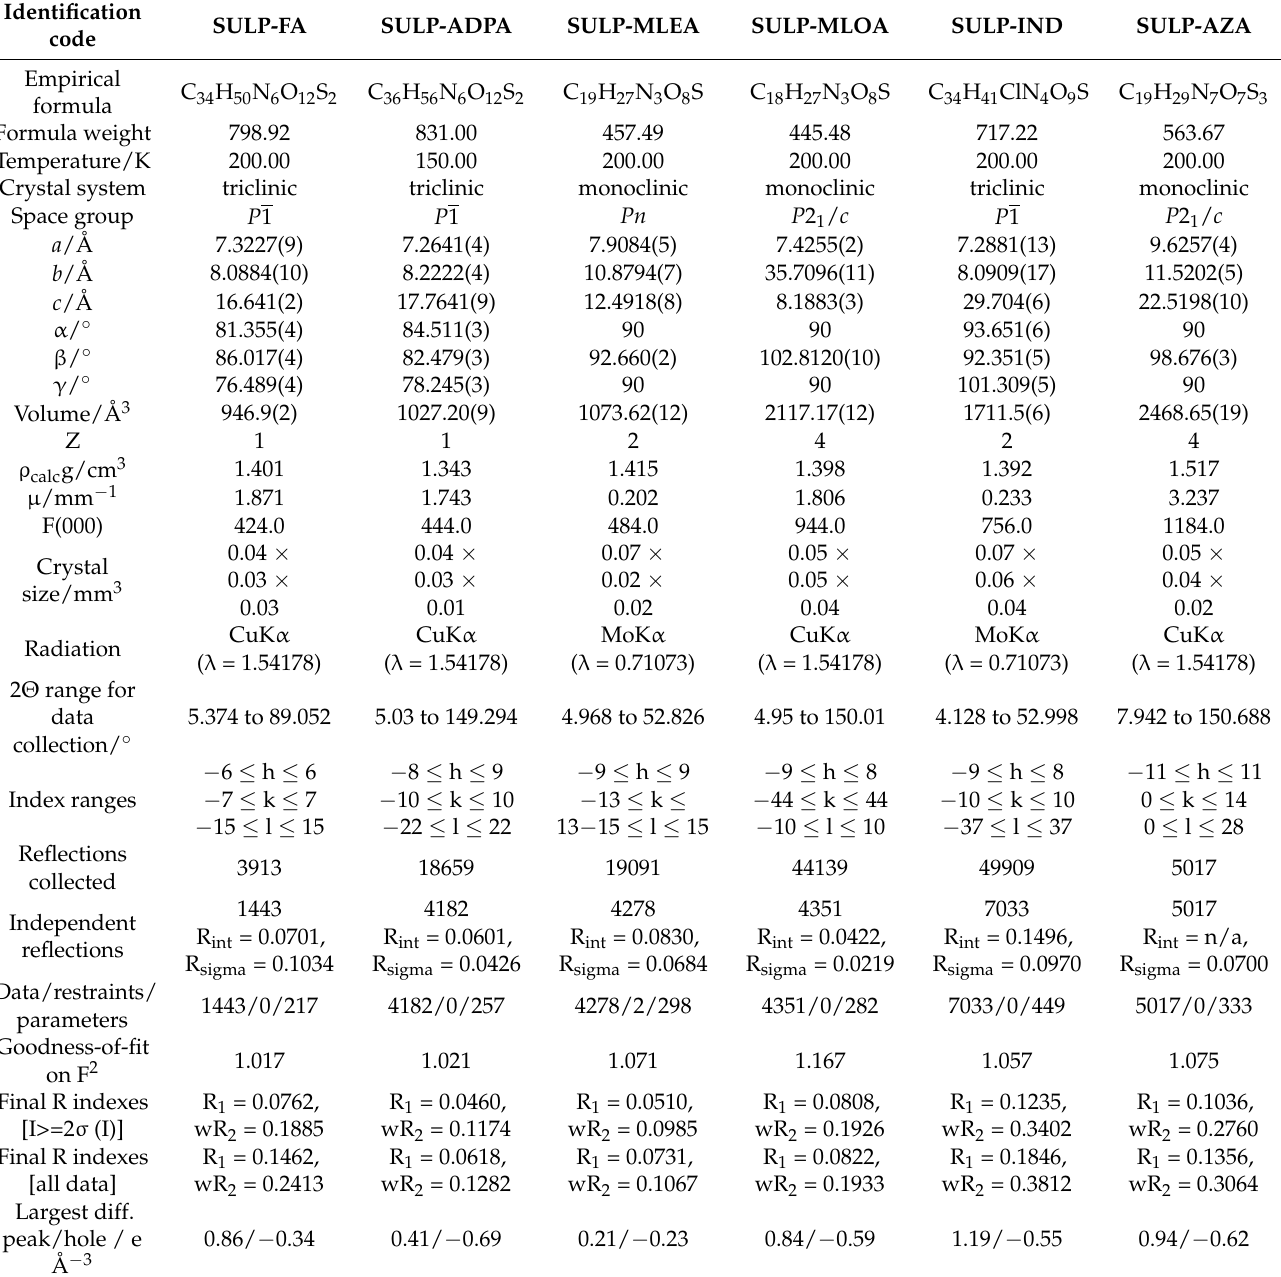
Table 1. Crystal data and structure refinement details for SULP-ADPA , SULP-FA , SULP-MLEA , SULP-MLOA , SULP-IND, and SULP-AZA